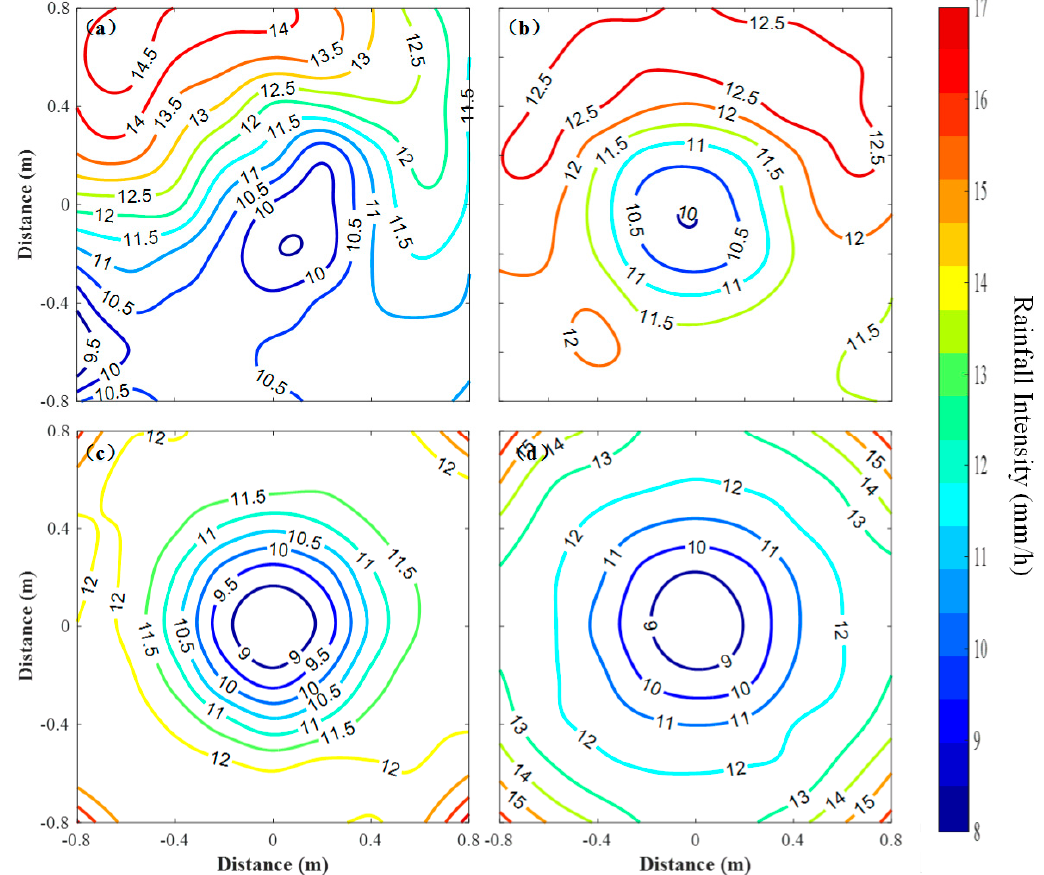
Figure 7. Rainfall intensities contour lines (units: mm/h) for the rainfall simulator with a rotary platform (RSRP) at a rotary speed of ( a ) 0 RPM, ( b ) 1 RPM, ( c ) 2 RPM, and ( d ) 2.4 RPM.